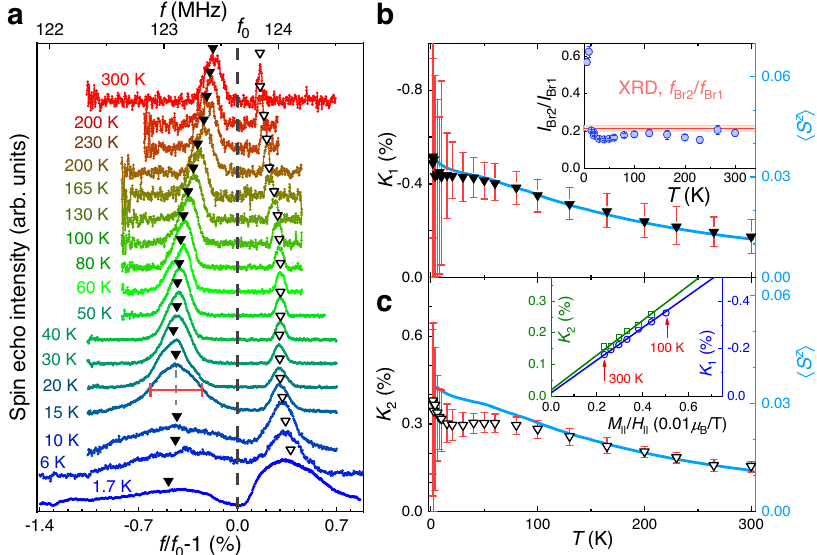
Fig. 2 Nuclear magnetic resonance spectra of YCu 3 (OH) 6.5 Br 2.5 . a Frequency-sweep spectra measured on the sample S 1 at a fi eld μ 0 H ∥ ~ 10.75 T (the reference frequency f 0 = 81 γ n μ 0 H ∥ ~ 123.64 MHz). The shifts of two lines, K 1 and K 2 , are marked by solid and hollow triangles, respectively. Temperature dependence of K 1 ( b ) and K 2 ( c ), with the bulk magnetization ( 〈 S z 〉 ) measured at μ 0 H ∥ = 10.75 T for comparison. The inset of b shows the ratio between the integrated intensities of 81 Br2 and 81 Br1 lines ( I Br2 / I Br1 ), as well as the stoichiometric ratio from x-ray diffraction 44 . Inset of c displays K 1 and K 2 shifts vs bulk susceptibility χ ∥ (i.e. M ∥ / H ∥ ). The red bars display the normalized frequency regions where the intensity is larger than half of the maximum value in b and c , and error bars on I Br2 / I Br1 show a standard error from the fi t.